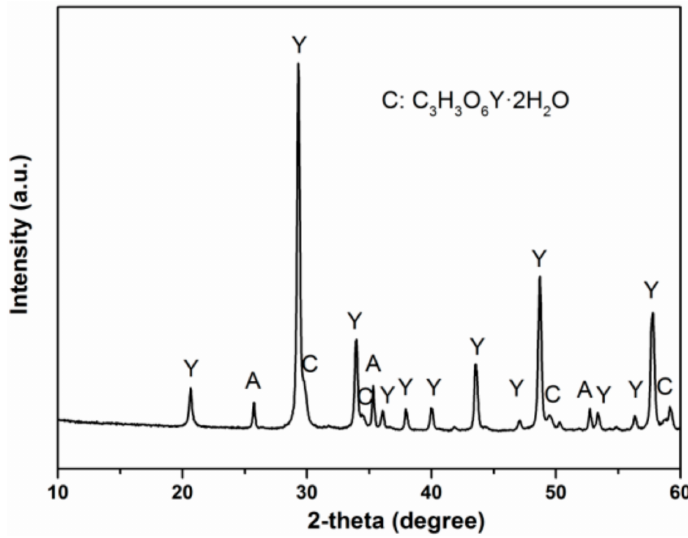
Figure 14. XRD pattern of the precursor powders after a